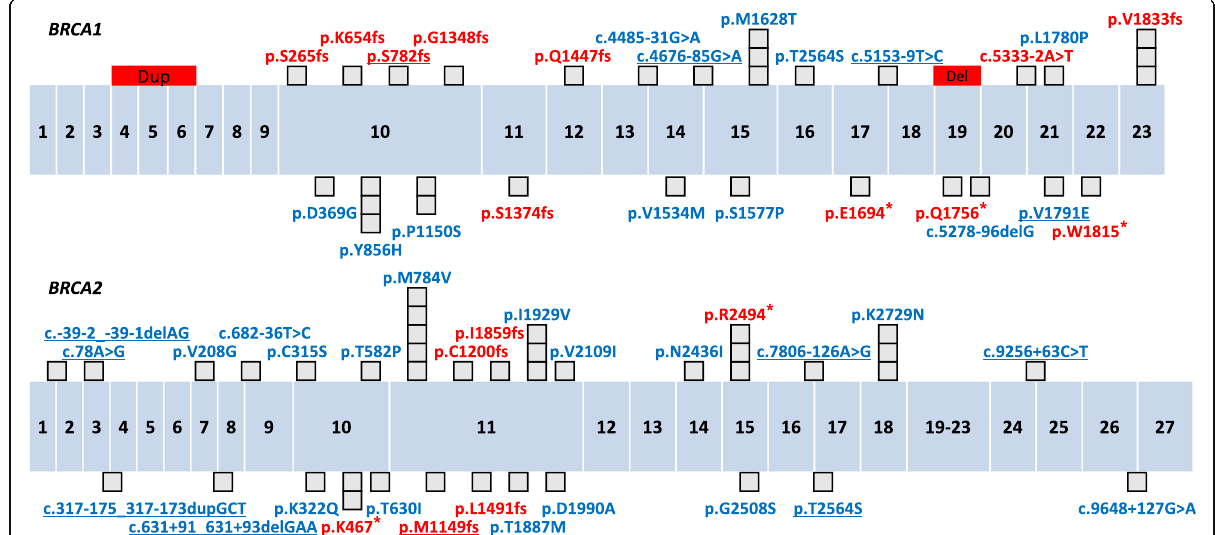
Fig. 1 Deleterious mutations ( red labels ) and variants of unknown significance ( blue labels ) of BRCA1/2 genes found in this study. The allele count of each variant is represented by the number of black square and novel variations are underlined. Red squares represent the detected large genomic rearrangements. Distances between variants and dimensions of each exons are not to